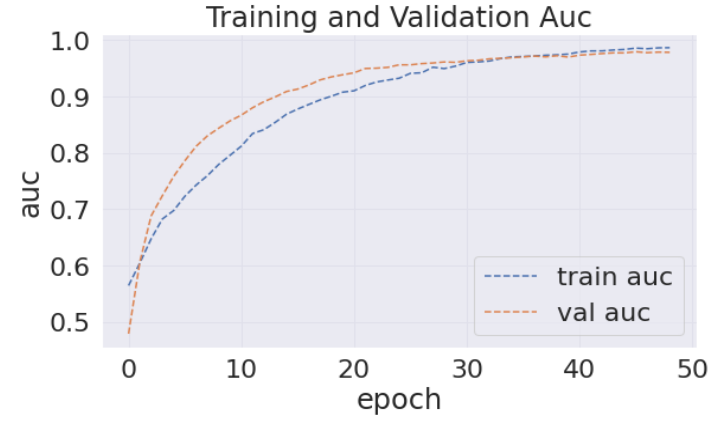
Figure 9. This figure demonstrates the training and validation value of AUC.